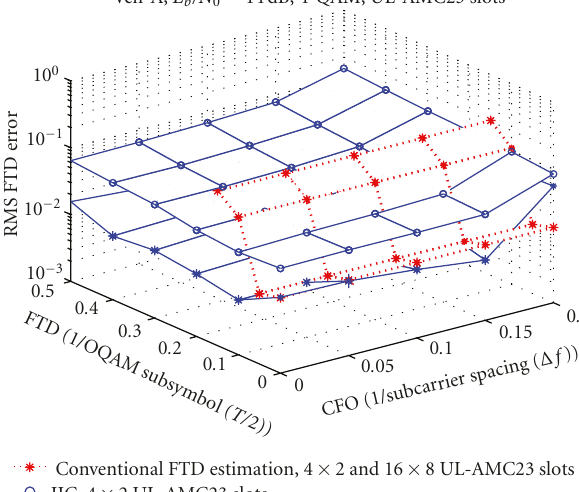
Figure 13: RMS error in FTD estimation versus CFO and FTD of the IIC FTD estimation method compared to classical FTD estimation. 4-QAM transmission of 4 × 2 and 16 × 8 AMC23 slots in Vehicular-A channel at E b /N 0 = 14 dB. Static user. No additional synchronization iteration.